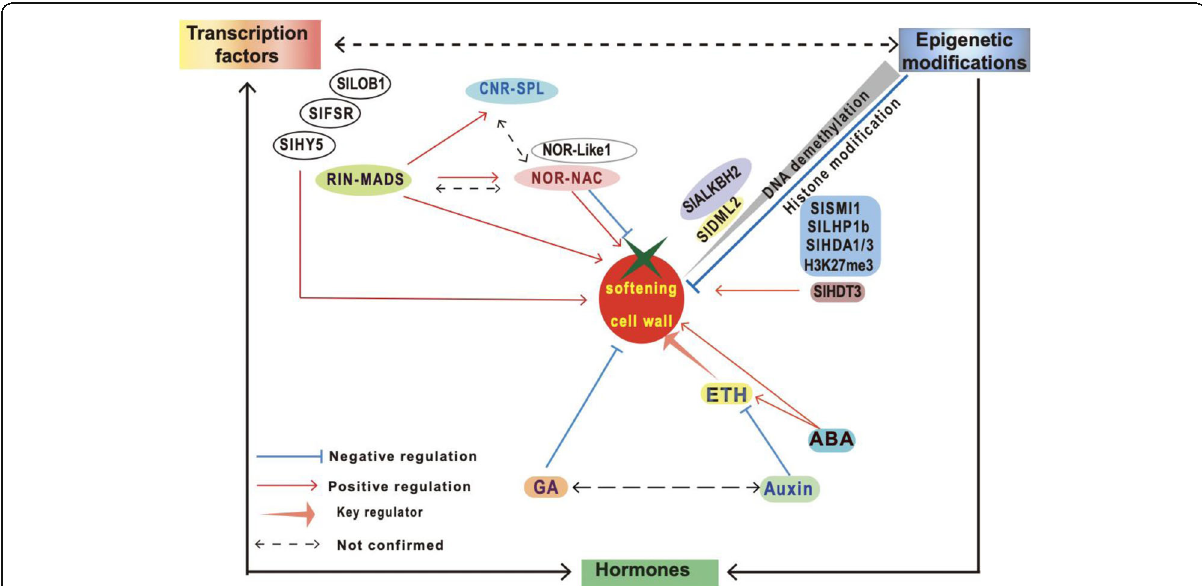
Fig. 1 Hormone, transcription and epigenome changes regulating softening in tomato. Tomato fruit softening is directly or indirectly regulated by a range of transcription factors (TFs). These include RIN-MADS, SPL-CNR and TFs from the NAC-box family such as NOR-Like1 along with SlLOB1, SlFSR and SlHY5. Ripening-associated softening processes are initiated and modulated by complicated network of feedback and crosstalk among different phytohormones including ethylene (ETH), abscisic acid (ABA), auxin and gibberellic acid (GA). Direct links between hormones and fruit texture regulation have been observed during tomato fruit ripening. Modifications to the epigenome especially DNA methylation and histones and RNA methylation are associated with ripening-related softening. SlDML2 is a key player regulating demethylation during tomato ripening. SlALKBH2, active m6A RNA demethylase, is necessary for normal tomato fruit ripening by direct targeting and stabilising transcript of SlDML2. Histone deacetylases SlHDA3 and SlHDA1, polycomb-group proteins SlMSI1 and SlLHP1b along with epigenetic mark H3K27me3 function as negative regulators of fruit softening, while histone deacetylases SlHDT3 plays a positive role in tomato fruit